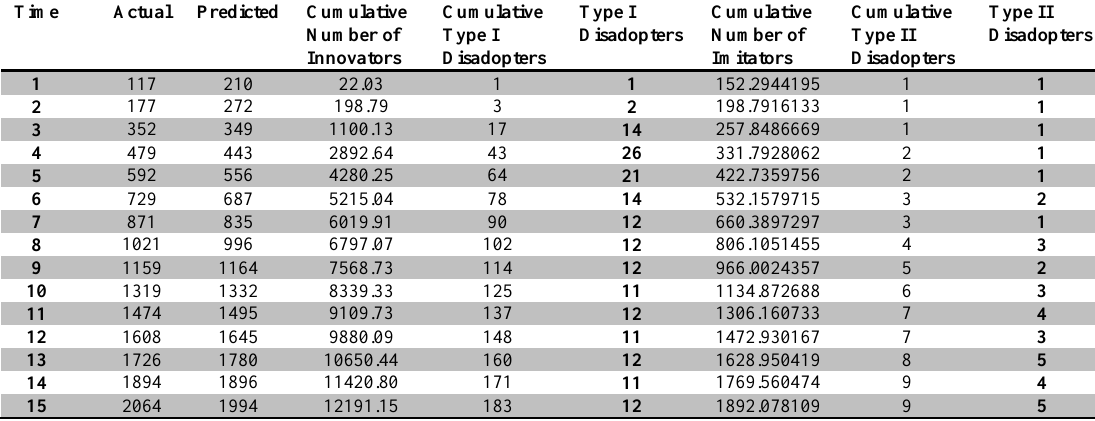
Table 2. Numerical measure of number of